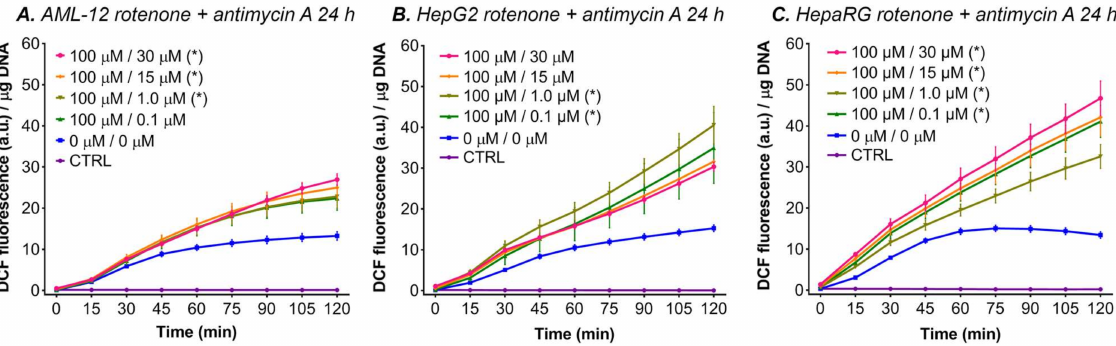
Figure 6. DCF fluorescence per µ g DNA after incubation with rotenone and antimycin A for 24 h in AML-12, HepG2, and HepaRG cells. The data are presented as mean ± SEM (n = 4/group). (*) = ∆ flu (flu at t = 120 − t = 0) significantly different vs. 0 µ M ( p < 0.05 one-way ANOVA, Dunnett’s post hoc test). The control (CTRL) cells were not incubated with DCFH 2 -DA. Abbreviations: DCF = 2 (cid:48) ,7 (cid:48) - dichlorofluorescein; a.u. = arbitrary